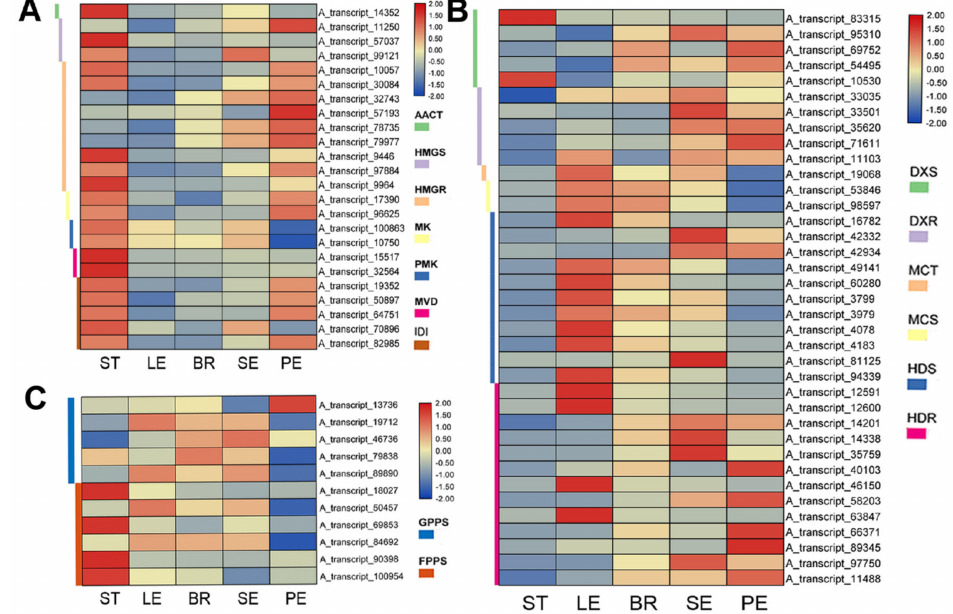
Figure 3. Transcript abundance profiles of genes encoding enzymes involved in the mevalonate (MVA) pathway ( A ), the methylerythritol pathway (MEP) pathway ( B ), and the biosynthesis of sesquiterpene skeleton ( C ) in different tissues of Origanum vulgare ‘Hot and